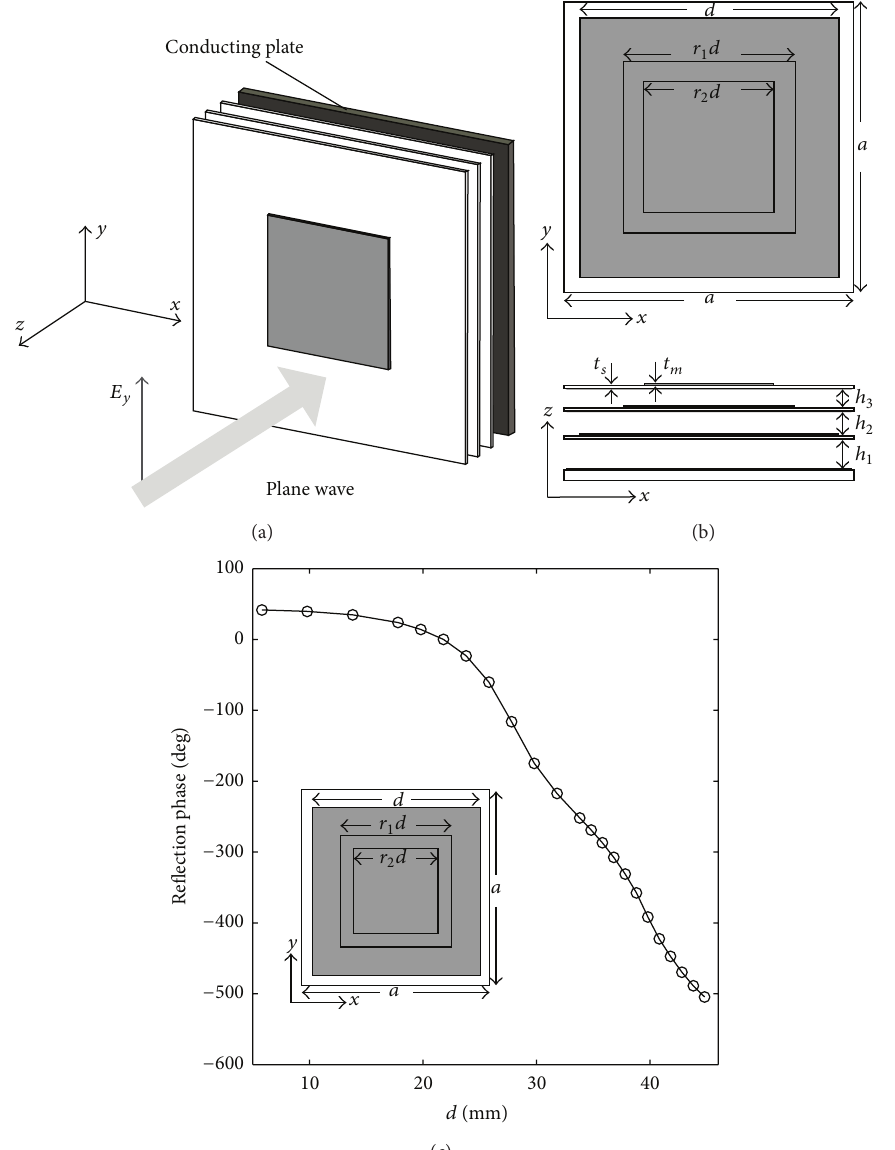
Figure 3: Reflecting element characterizing three-layer stacked square patches of variable size. (a) Oblique view. (b) Elevation view and side view. In the elevation view, the second and third substrate layers are omitted to show all the three patch layers clearly. (c) Typical design curve relating reflection phase at 4GHz with the dimension 𝑑 for the stacked-patch elements with certain